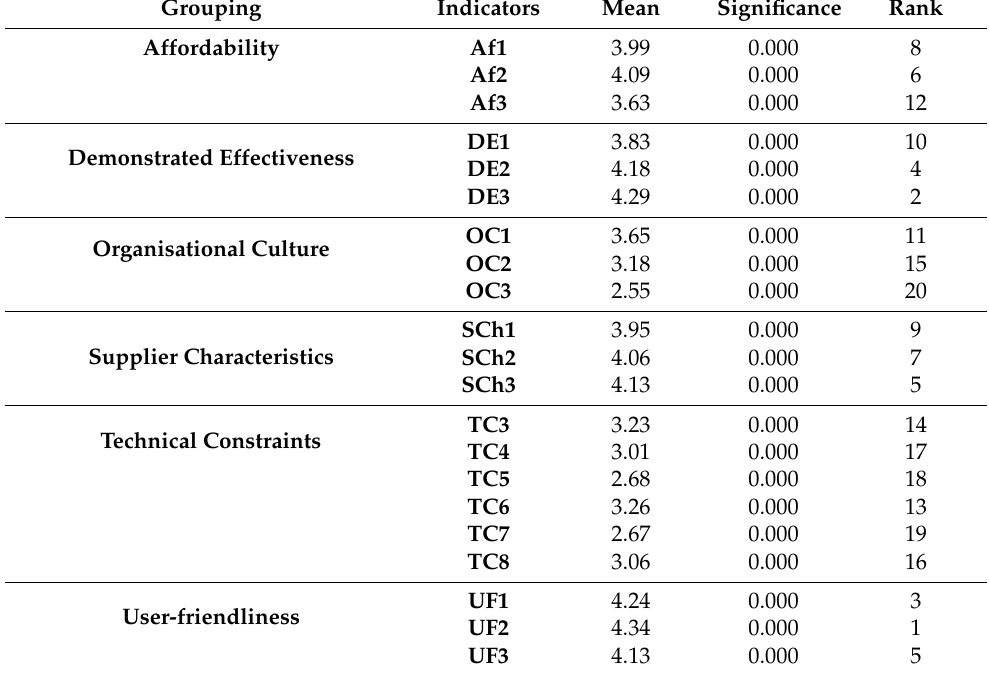
Table 6. Rank of the